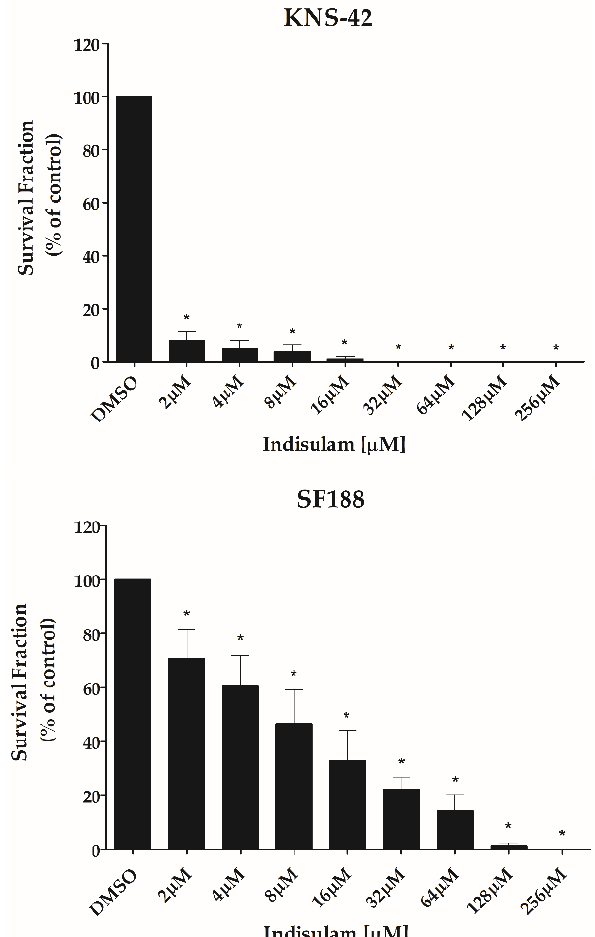
Figure 4. Indisulam reduces the clonogenic capacity of pHGG cell lines. SF188 and KNS-42 cells were pre-incubated in hypoxia-mimic conditions (CoCl 2 at 50 μM and 100 μM, respectively) for 24 h. The cells were treated with Indisulam for 48 h and further cultured for 9 to 11 days to assess colony formation. Cells treated with vehicle alone (DMSO) served as controls. The colonies formed were normalized to the plating efficiency (FP) and the survival fraction obtained was compared to the control (DMSO). * p < 0.001 indicates a significant difference between the treated cells and the control.